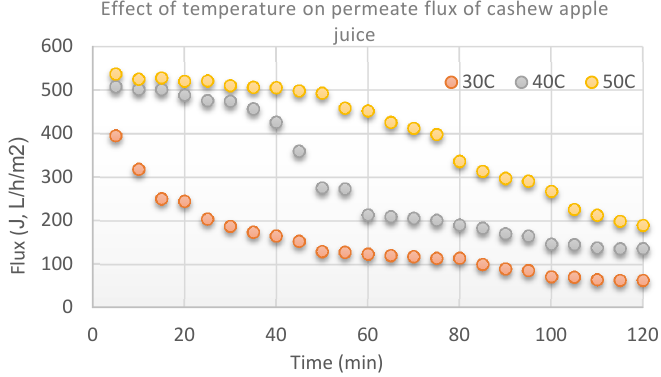
Figure 10. Effectoftemperatureonpermeatefluxofcashewapplejuice(TMP=1.5bars; membrane = 500